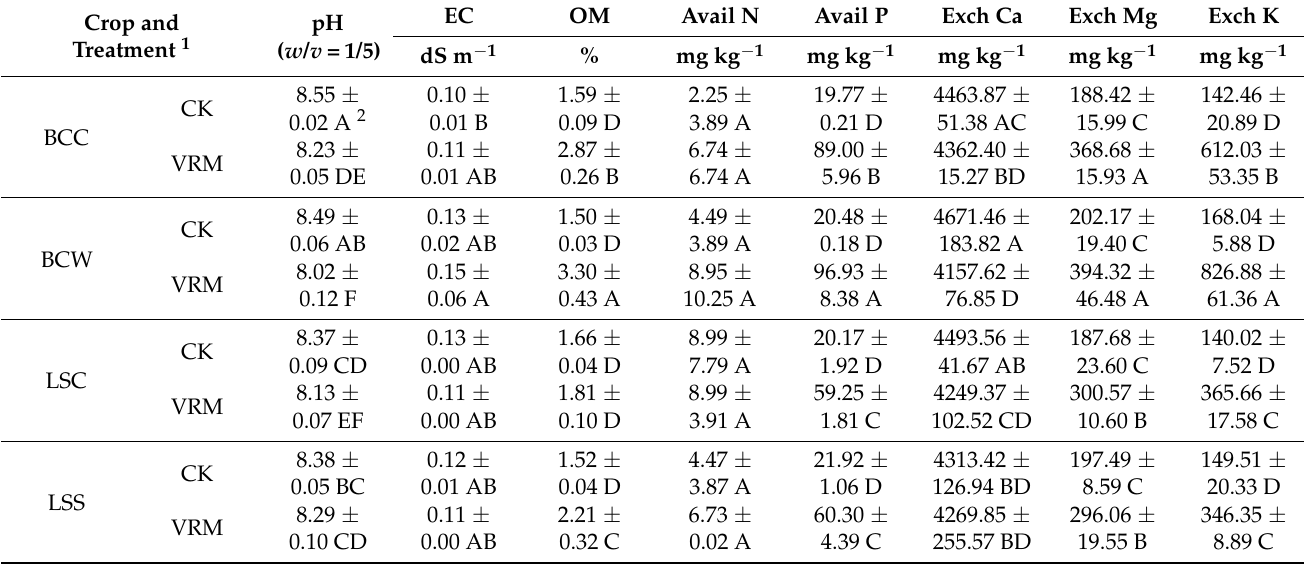
Table 1. The soil properties of Ti-132 under different treatments.